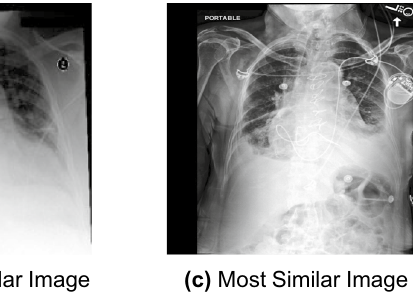
Figure 1. Pleural Effusion test image and the least and most similar images of the catalogue according to our board-certified radiologist (in terms of disease and disease severity). The overall most similar image would be ( b ). However, such matching is not of radiological